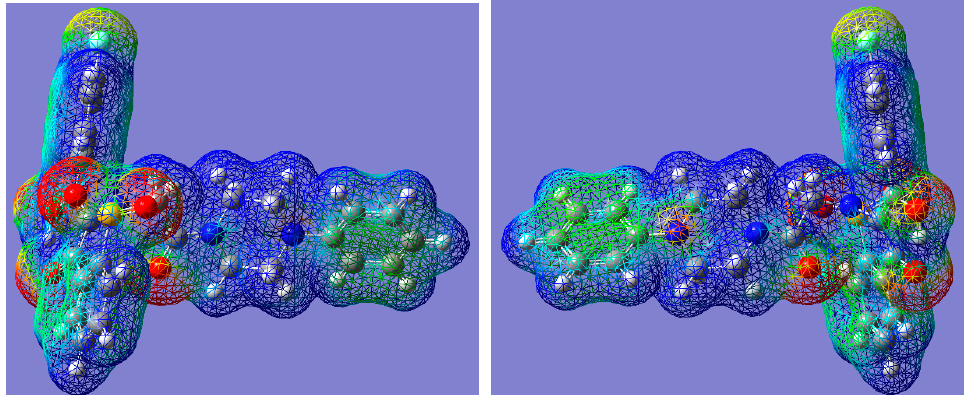
Figure 4. Three-dimensional molecular electrostatic potential map for 7i . View from one side ( left ) and the other rotated by 180° ( right ). Color code: − 0.05 eÅ − 1 (red) to +0.05 eÅ − 1 (blue).